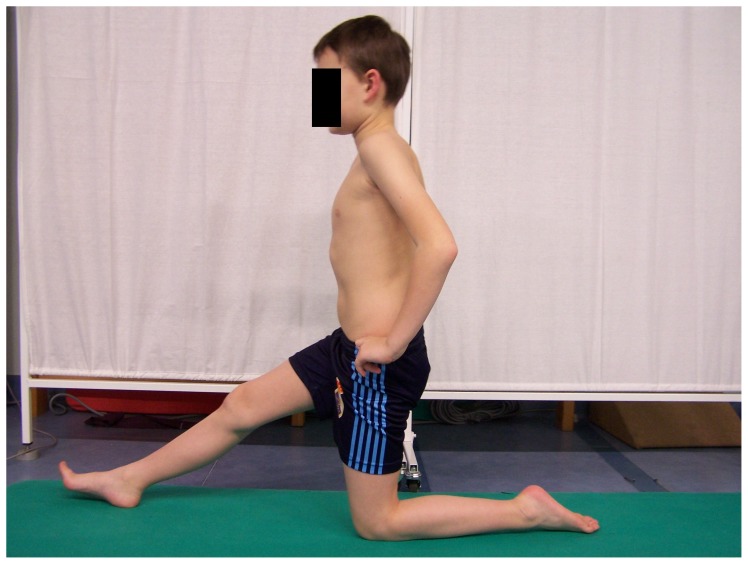
Post-isometric hamstring relaxation.